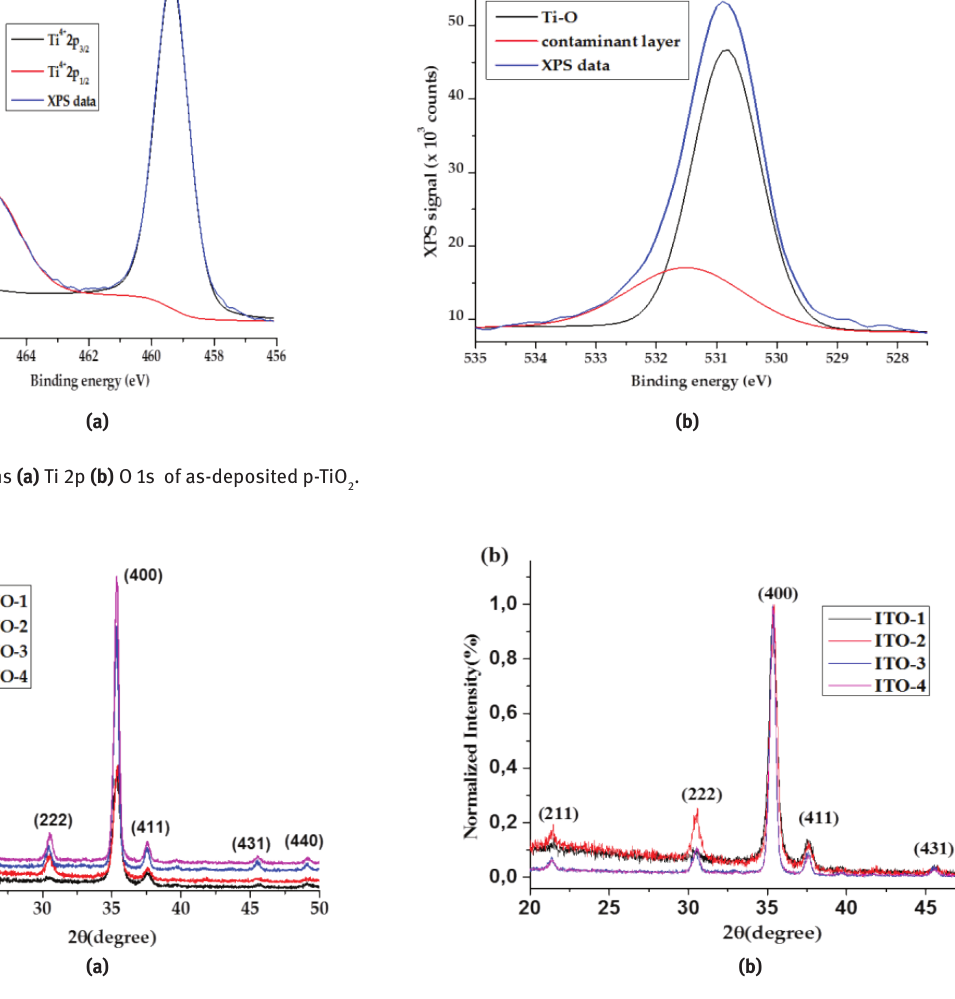
Fig 3. (a) XRD graphs (b) Normalized XRD graphs for patterns of ITO films Figure 3: (a) XRD graphs (b) Normalized XRD graphs for patterns of ITO Table 1: The atomic(at.%) concentrations of d-TiO of TiO -based bilayer. 2